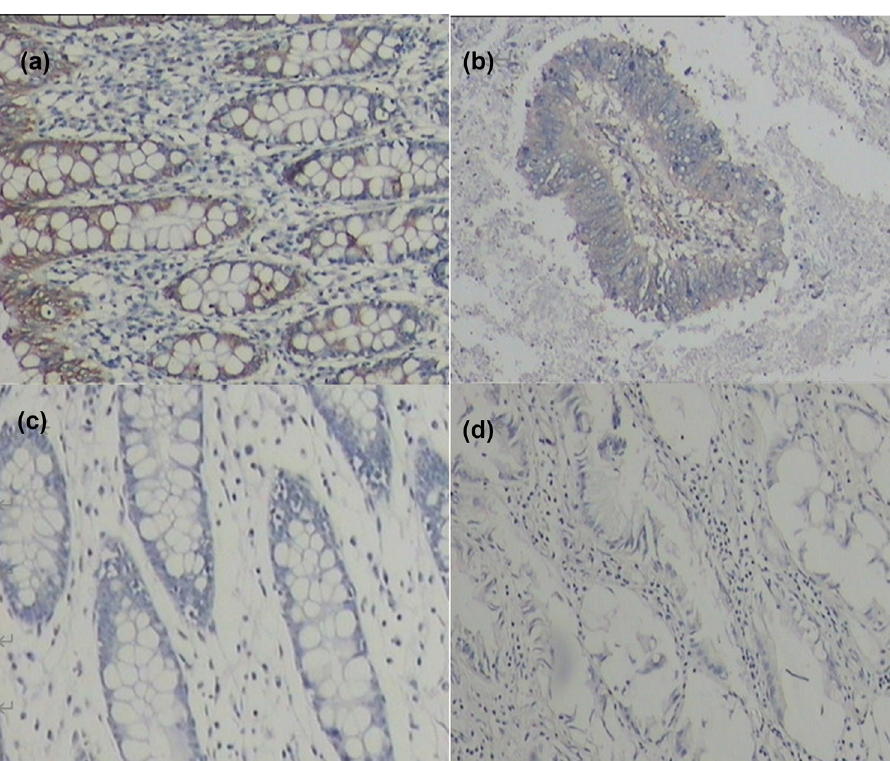
Figure 1: IHC staining of CRC and adjacent non - tumor tissues. ( a ) Positive expression of DNM3 in non - cancerous adjacent colorectal tissues; ( b ) positive expression of DNM3 in CRC tissues; ( c ) negative expression of DNM3 in non - cancerous adjacent colorectal tissues; ( d ) negative expression of DNM3 in CRC tissues. The positive area was stained with sappanwood purple.